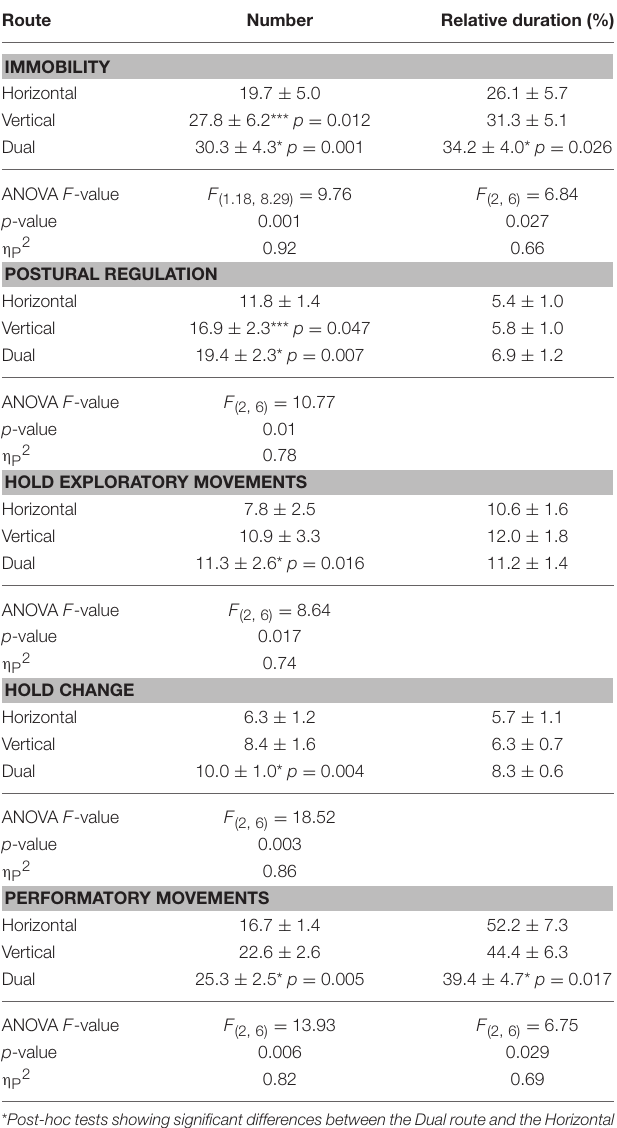
TABLE 1 | Effect of route design on the climbing states (i.e., number of events and total relative duration of the state expressed in % of the whole ascent duration).